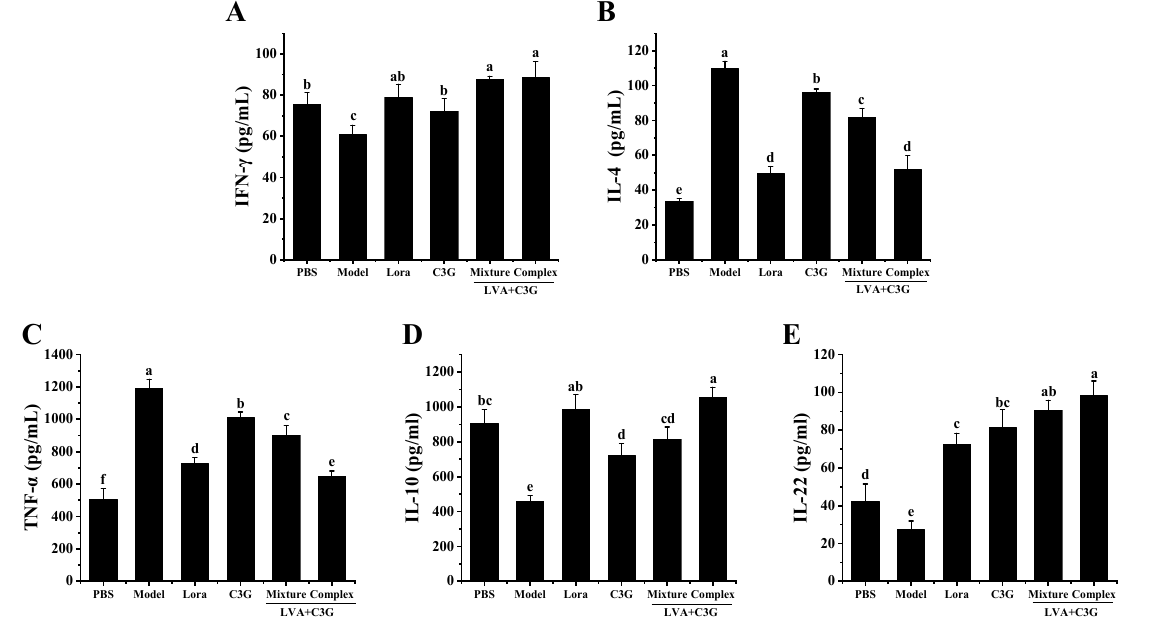
Figure 5. The effect of the C3G-associated samples on the intestinal immune-related cytokines. ( A ) IFN- γ . ( B ) IL-4. ( C ) TNF- α . ( D ) IL-10. ( E ) IL-22. Significant differences ( p < 0.05) are identified by different letters.